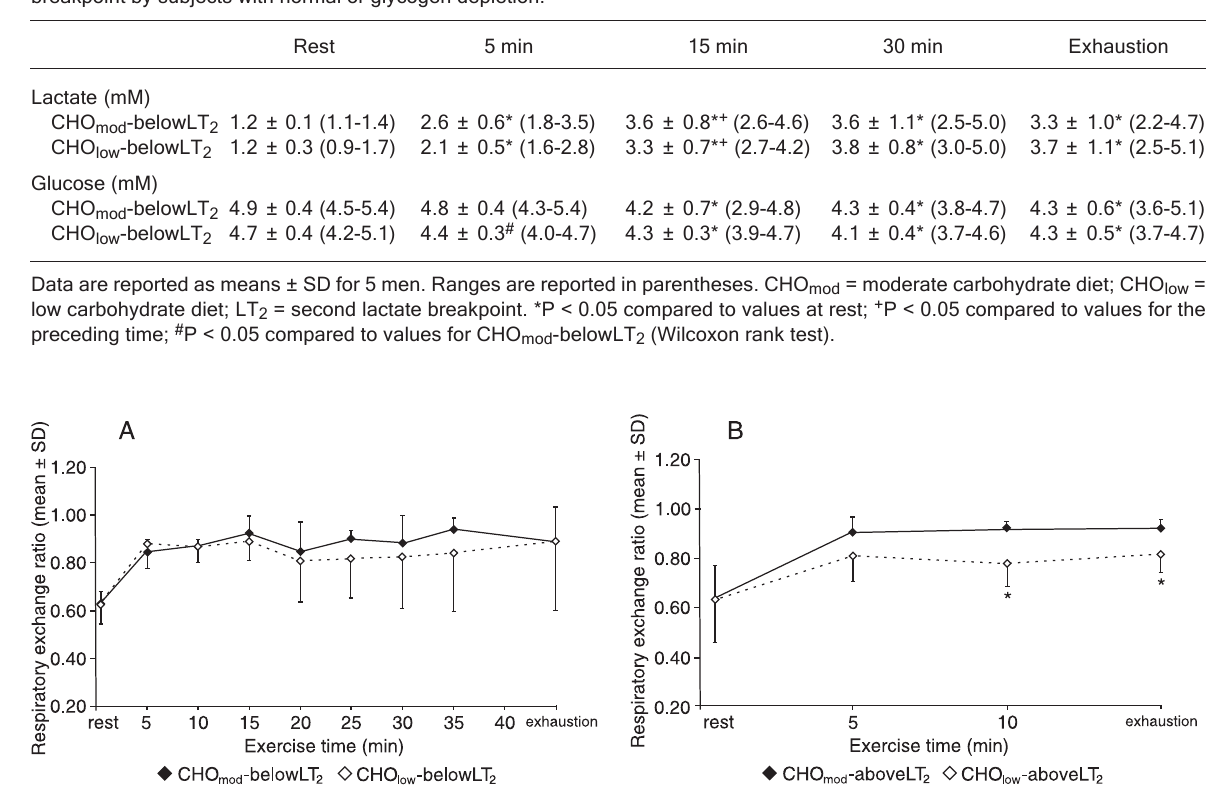
Table 2. Changes in blood lactate and glucose concentration as a function of time during exercise performed below the second lactate breakpoint by subjects with normal or glycogen